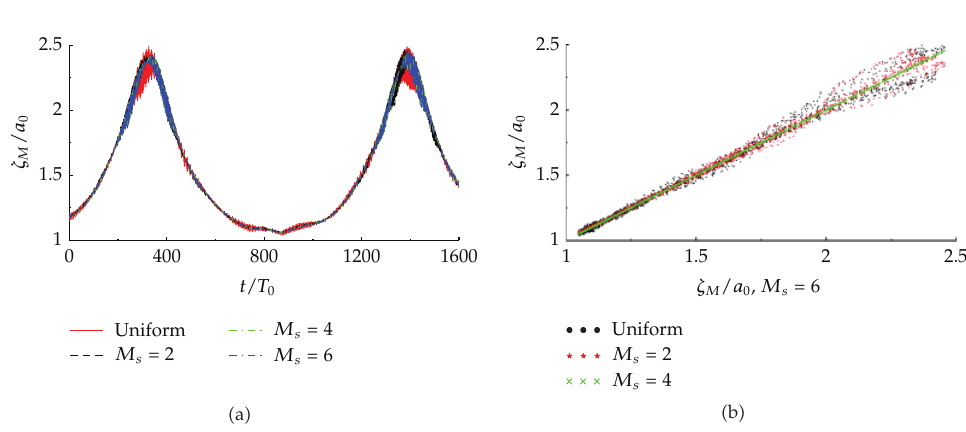
Figure 3: The maximum wave crest histories (cid:2) a (cid:3) and scatter diagram (cid:2) b (cid:3) of Stokes-modulated wave train for ε 0 (cid:7) 0 . 05, r 1 (cid:7) 0 . 1 with di ff erent initial carrier